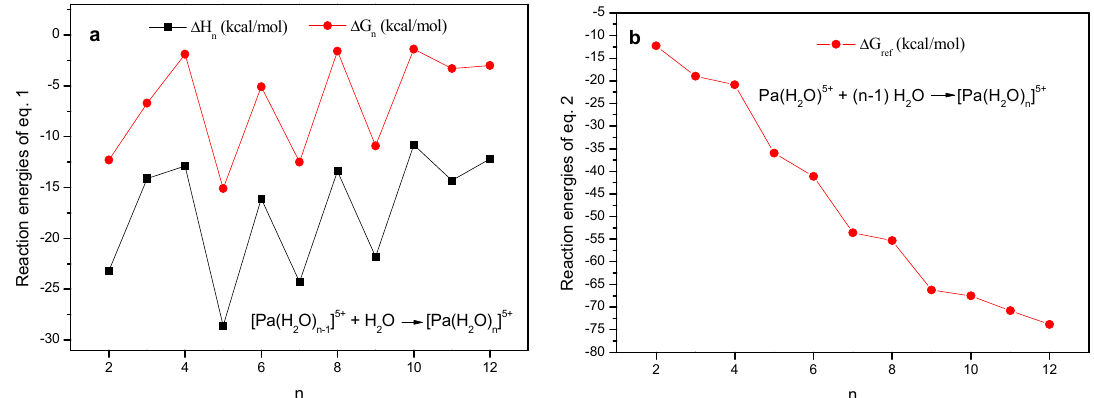
Figure 4. Correlation between thermodynamic data and number of water ligands on [Pa(H 2 O) n ] 5+ for Equations (1) ( a ) and (2) ( b ). The enthalpies and Gibbs free energies are calculated with the B3LYP-D3(BJ)/GEN/IEF-PCM//B3LYP/GEN /IEF-PCM method (for details see Table 2 caption).